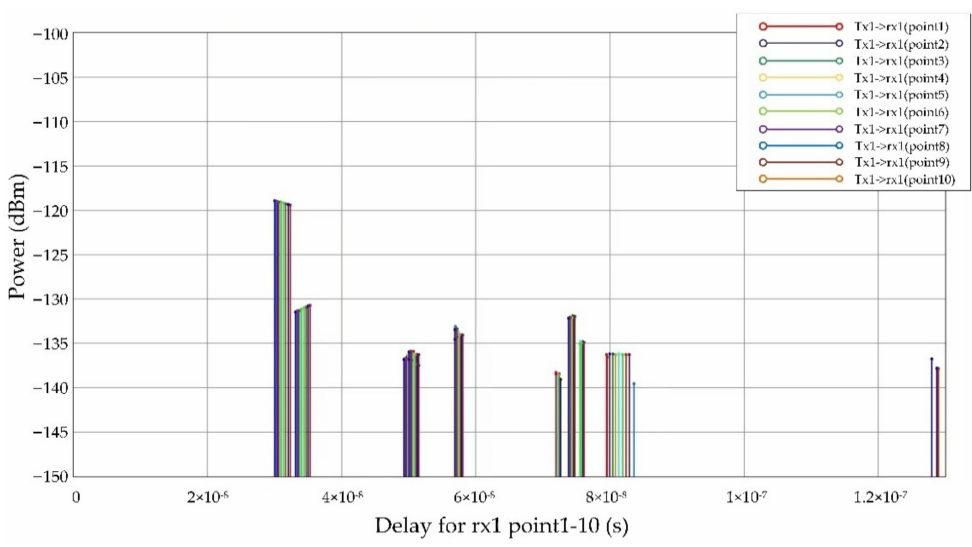
Figure 8. Simulation result of RSS.